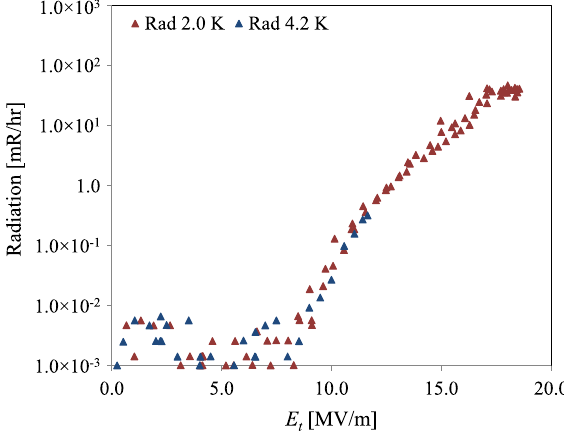
FIG. 12. Field emission at 4.2 and 2.0 K rf tests.